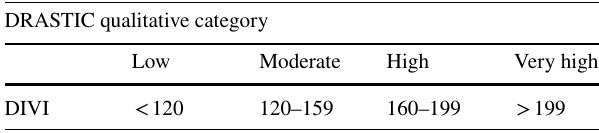
Table 3 DRASTIC index ranges for qualitative vulnerability catego- ries (Lobo-Ferreira and Olivereira 2004) DRASTIC qualitative